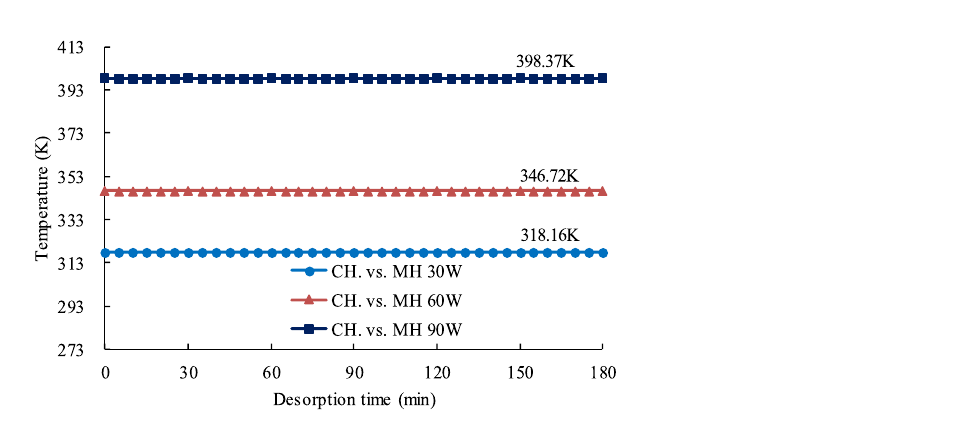
Figure 8. Coal sample temperatures during CH desorption